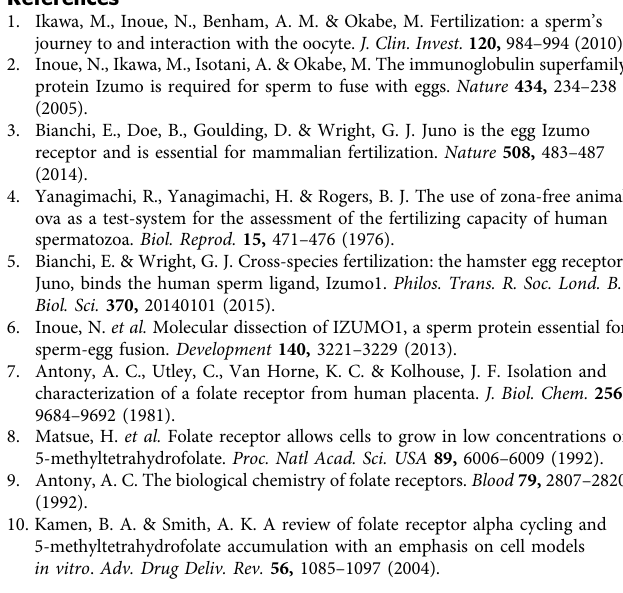
Sperm-binding assay . HEK293T cells were seeded in six-well plates and trans- fected with the pCAGGS vectors encoding wild-type or mutant JUNOs, as previously described 24 . For mock transfection, pCAGGS vector encoding enhanced green fluorescent protein (cytosolic) was used. After 60h, the cells were washed, incubated with 800 m l of TYH medium per well, and then mixed with capacitated spermatozoa from transgenic male mice carrying mitochondrial DsRed2 (ref. 29), at a final concentration of 2 (cid:3) 10 5 cells per ml. After an incubation at 37 (cid:2) C for